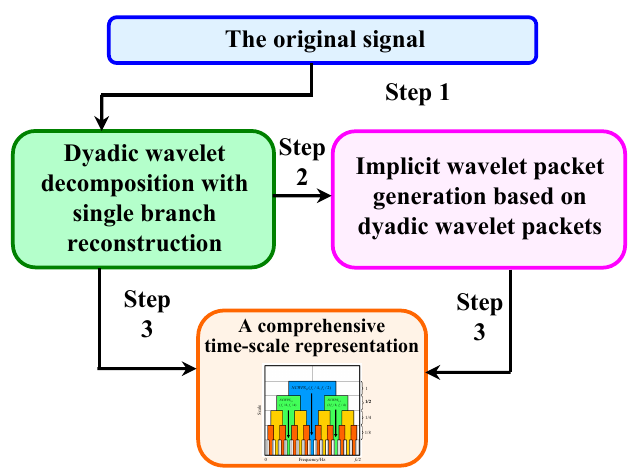
Figure 5. The time domain waveform of the displacement signal.